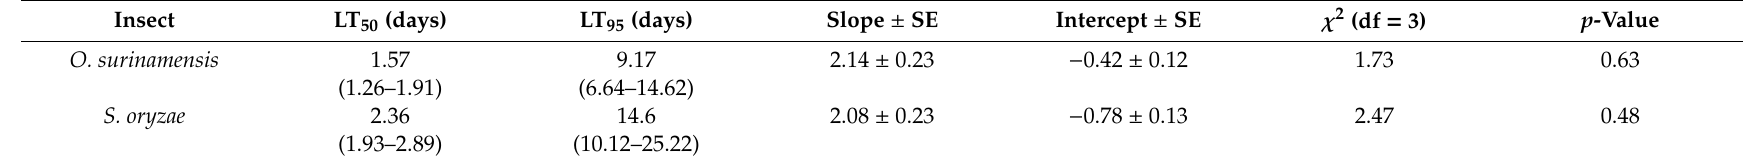
Table 4. Lethal time values of T. kotschyanus essential oil on O. surinamensis and S.